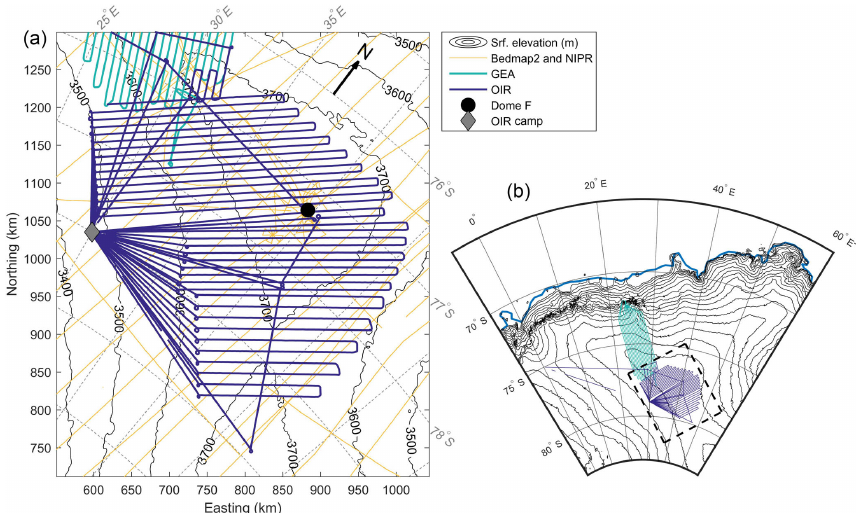
Figure 1. The Dome Fuji region in East Antarctica (the left-hand figure is a polar stereographic projection with standard parallel of − 70 ◦ ). The map shows the coverage of the new radar survey radar lines in 2014/15 (green) and 2016/17 (blue), and the yellow lines show the Bedmap2 data (Fretwell et al., 2013). Dome Fuji station and the OIR field camp are marked with a black dot and a grey diamond, respectively. Surface contours from Bedmap2 are shown in